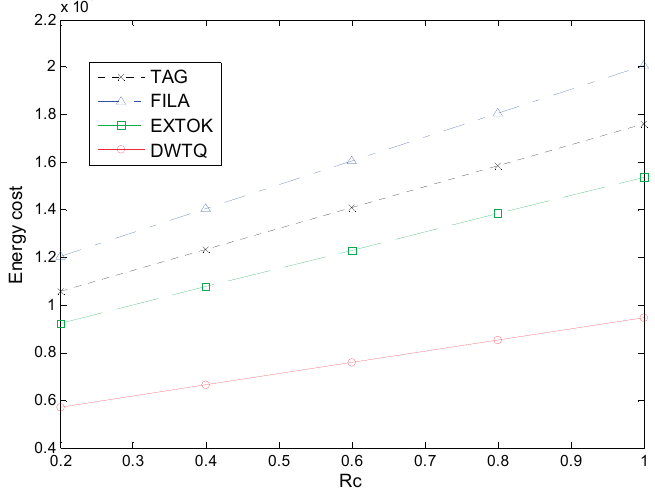
Figure 17. Total energy cost for a node in a day with different (cid:1844)